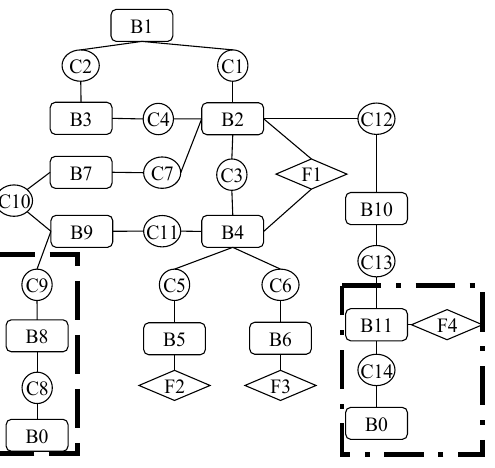
Figure 4. Connection relationships of the front landing structure of a carrier-based aircraft.